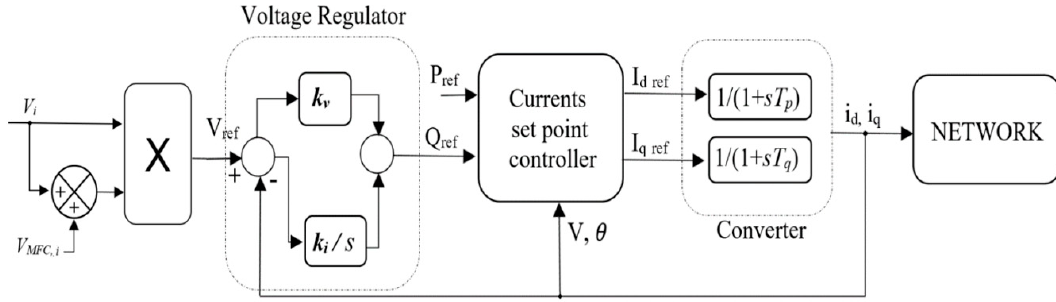
Table 1. Key parameters of the simulation study.